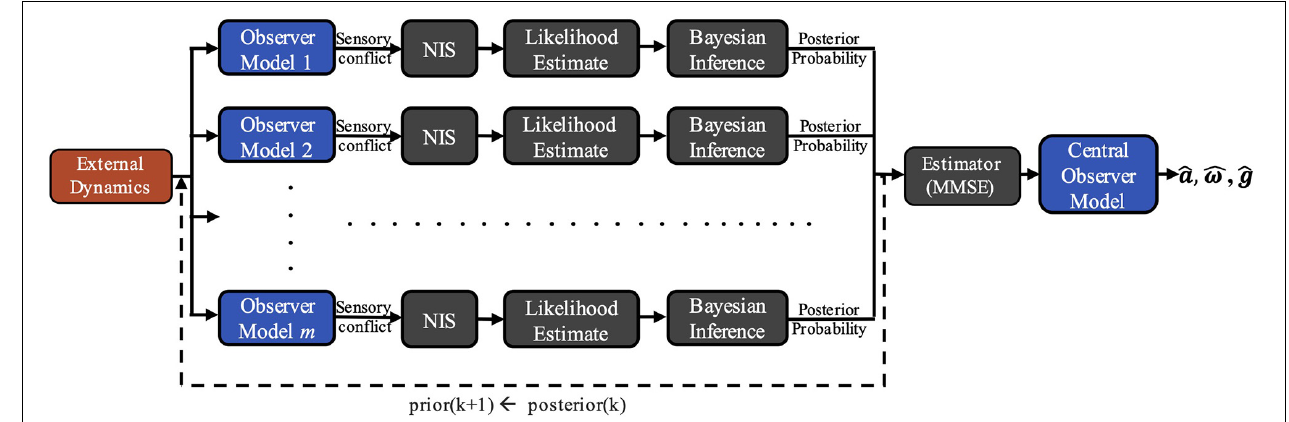
FIGURE 2 | COMPASS model framework. External dynamics are inputted into m parallel observer models, each incorporating an alternative hypothesis for the magnitude of gravity, | b g |. Differences between expected and actual sensory afferent signals in each observer generate sensory conflict, allowing for Bayesian posterior probability updates for each gravity hypothesis after being weighted and normalized by the Normalized Innovation Squared (NIS) function. A central estimate is derived from the posterior probability distribution and is inputted into a final Central Observer Model, yielding perceptual estimates of b g , b a , and b ω